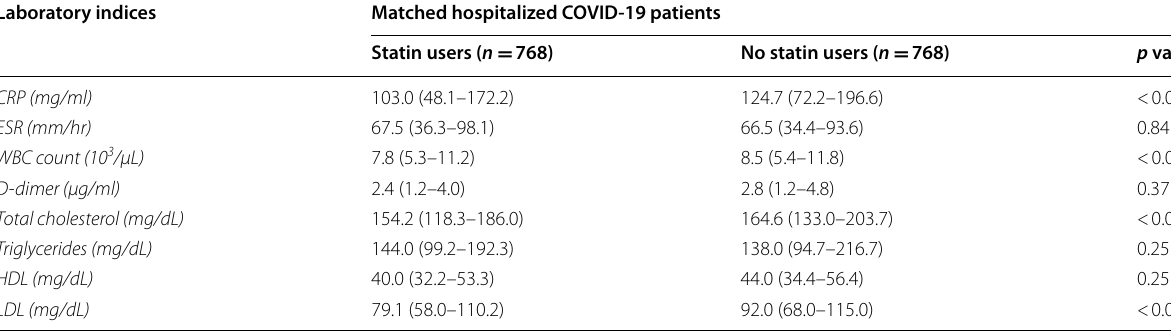
Table 2 Laboratory indices in matched cohort study pool